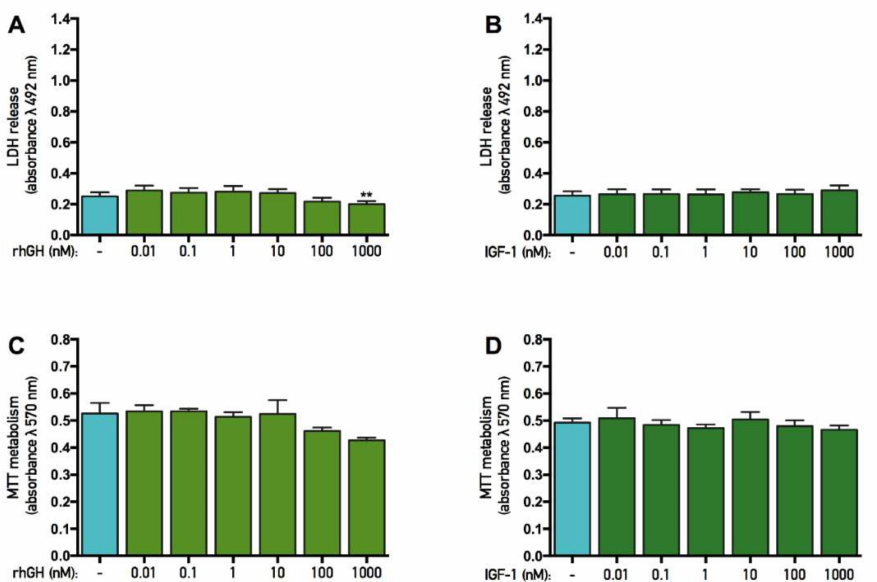
Figure 1. Effects of recombinant human growth hormone and insulin-like growth factor-1 on untreated cells. Mitochondrial function was assessed by tetrazolium bromide (MTT) assay and membrane integrity was assessed by lactate dehydrogenase (LDH) assay. Recombinant growth hormone (rhGH) and insulin-like growth factor-1 (IGF-1) were added for three consecutive days before analysis. ( A ) Effects of rhGH on membrane integrity. A significant decrease in LDH was observed using 1000 nM rhGH compared with control. ( B ) Effects of IGF-1 on membrane integrity. No significant effects were observed when cells were treated with IGF-1. ( C ) Effects of rhGH on mitochondrial function. No significant effects were observed when cells were treated with rhGH. ( D ) Effects of IGF-1 on mitochondrial function. No significant effects were observed when cells were treated with